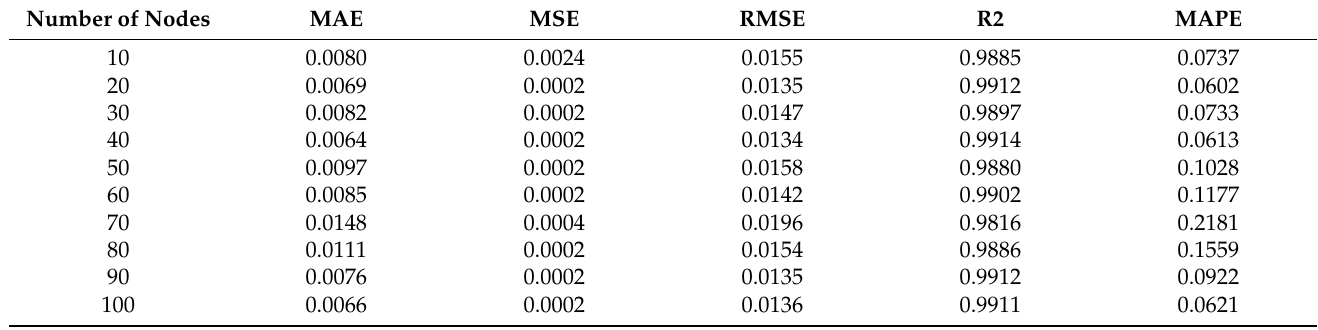
Table 2. Performance metrics of GRU for different number of nodes on the train set.